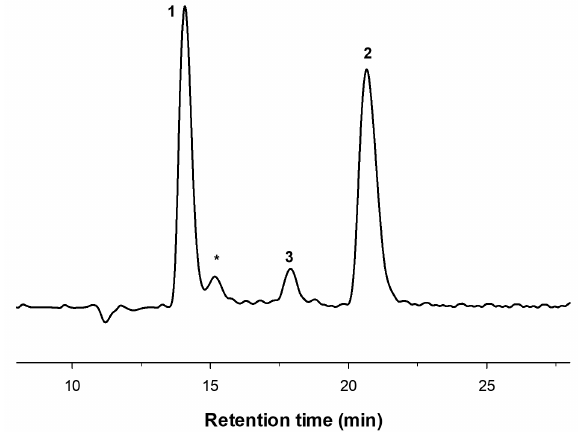
Figure 3. HPAEC-PAD chromatogram of the chitooligosaccharides obtained with chitinase Chit42 employing chitin (colloid). Reaction conditions: 1% (w/v) colloidal chitin, 10% (v/v) chitinase, 70 mM potassium phosphate pH 6.0. Identified peaks: (1) GlcNAc; (2) (GlcNAc) 2 ; (3) (GlcNAc) 3 .